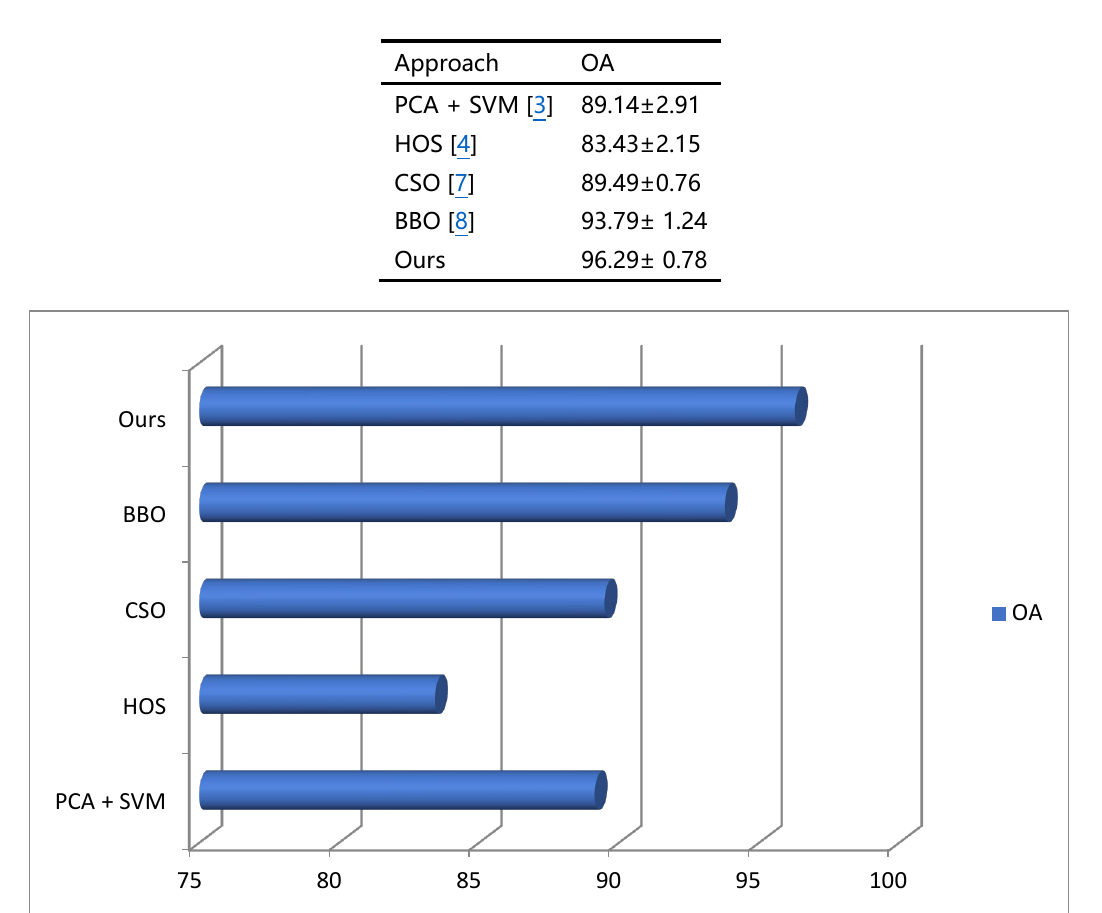
Figure 12. Comparison with each